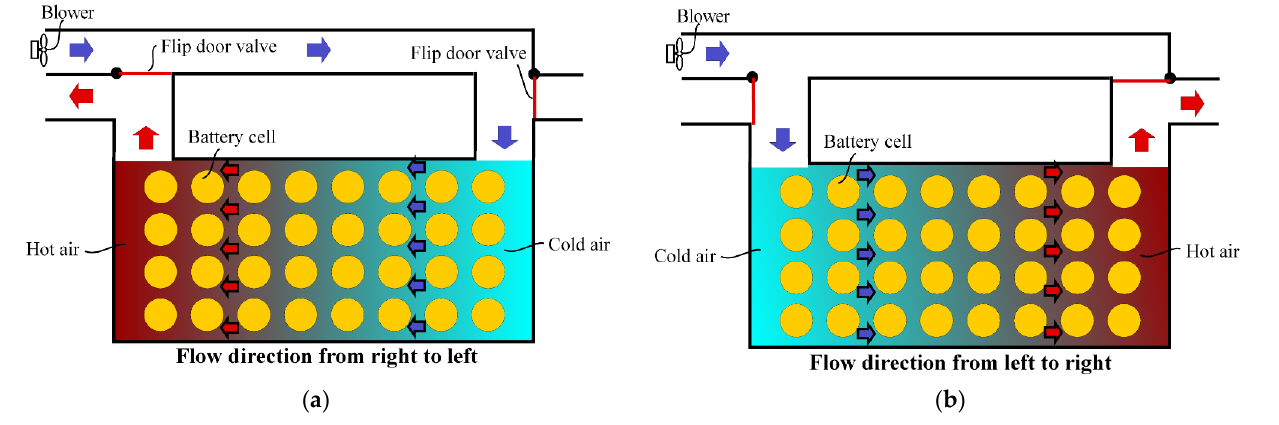
Figure 18. The setup of reciprocating cooling flow configuration in a 2-D schematic view is presented for a pack with 4 by 8 cells. Flow directions are altered periodically as ( a ) first half cycle (right to left) and ( b ) second half cycle (left to right). Reprinted with permission from [35]. Copyright 2011 Elsevier.